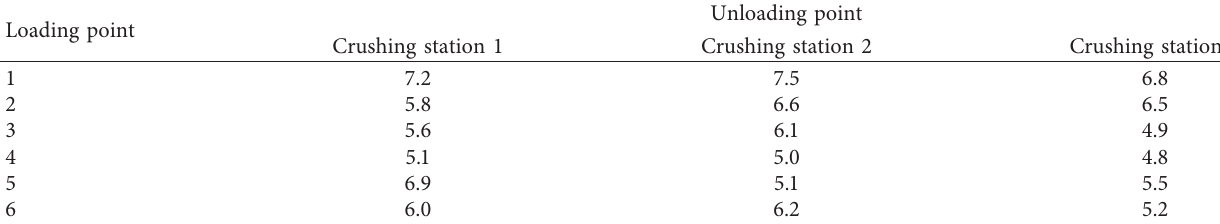
Table 3: Empty truck running time